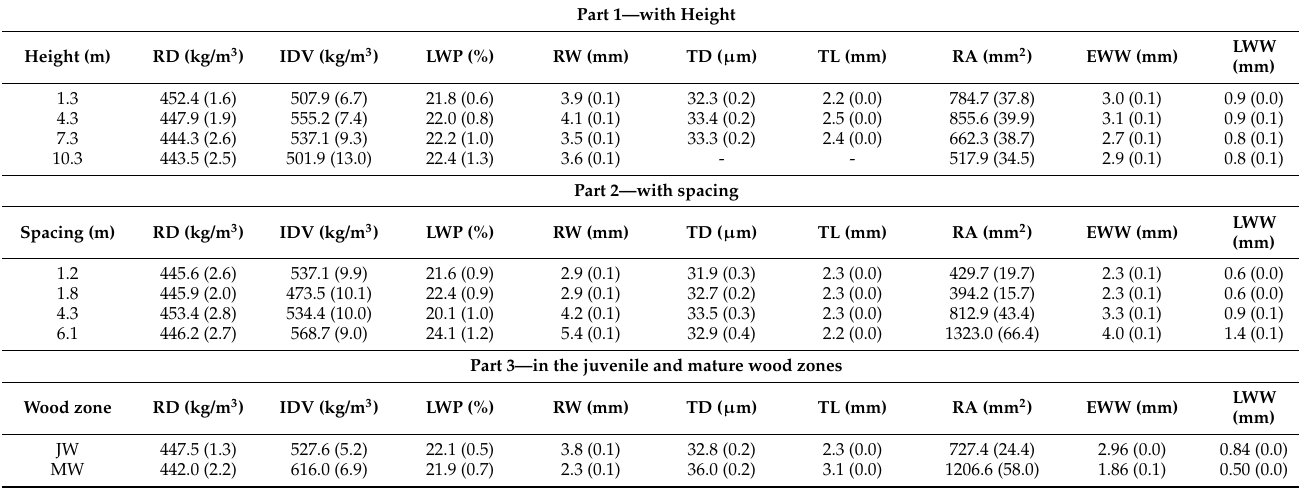
Table 3. Mean values (and standard error) of wood quality